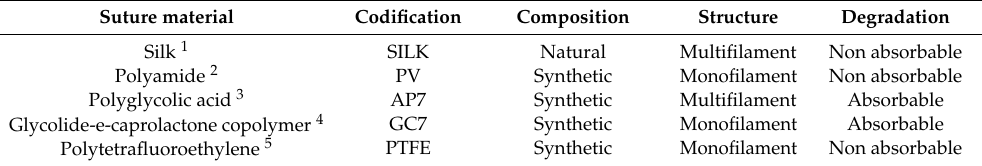
Table 1. Five suture materials were used in order to assess their properties.